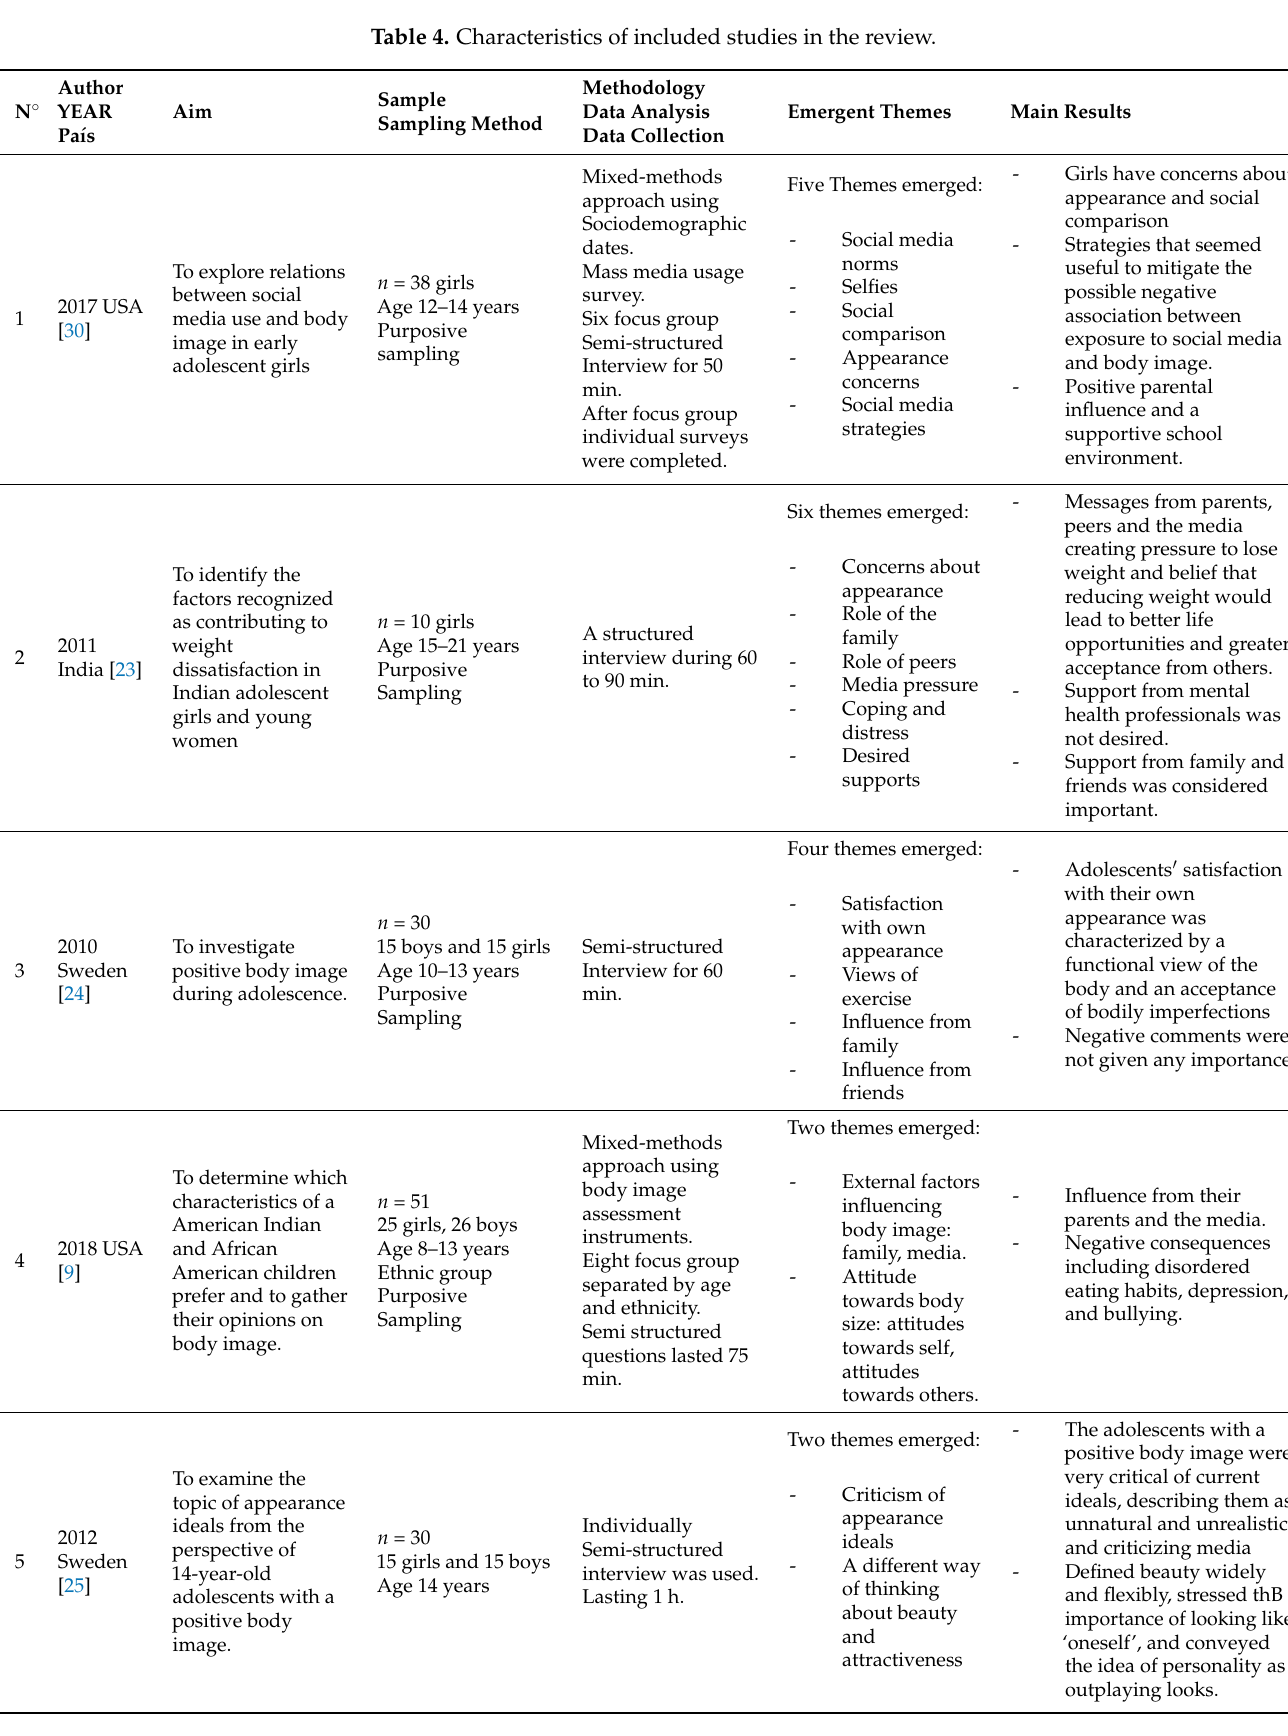
Table 4. Characteristics of included studies in the